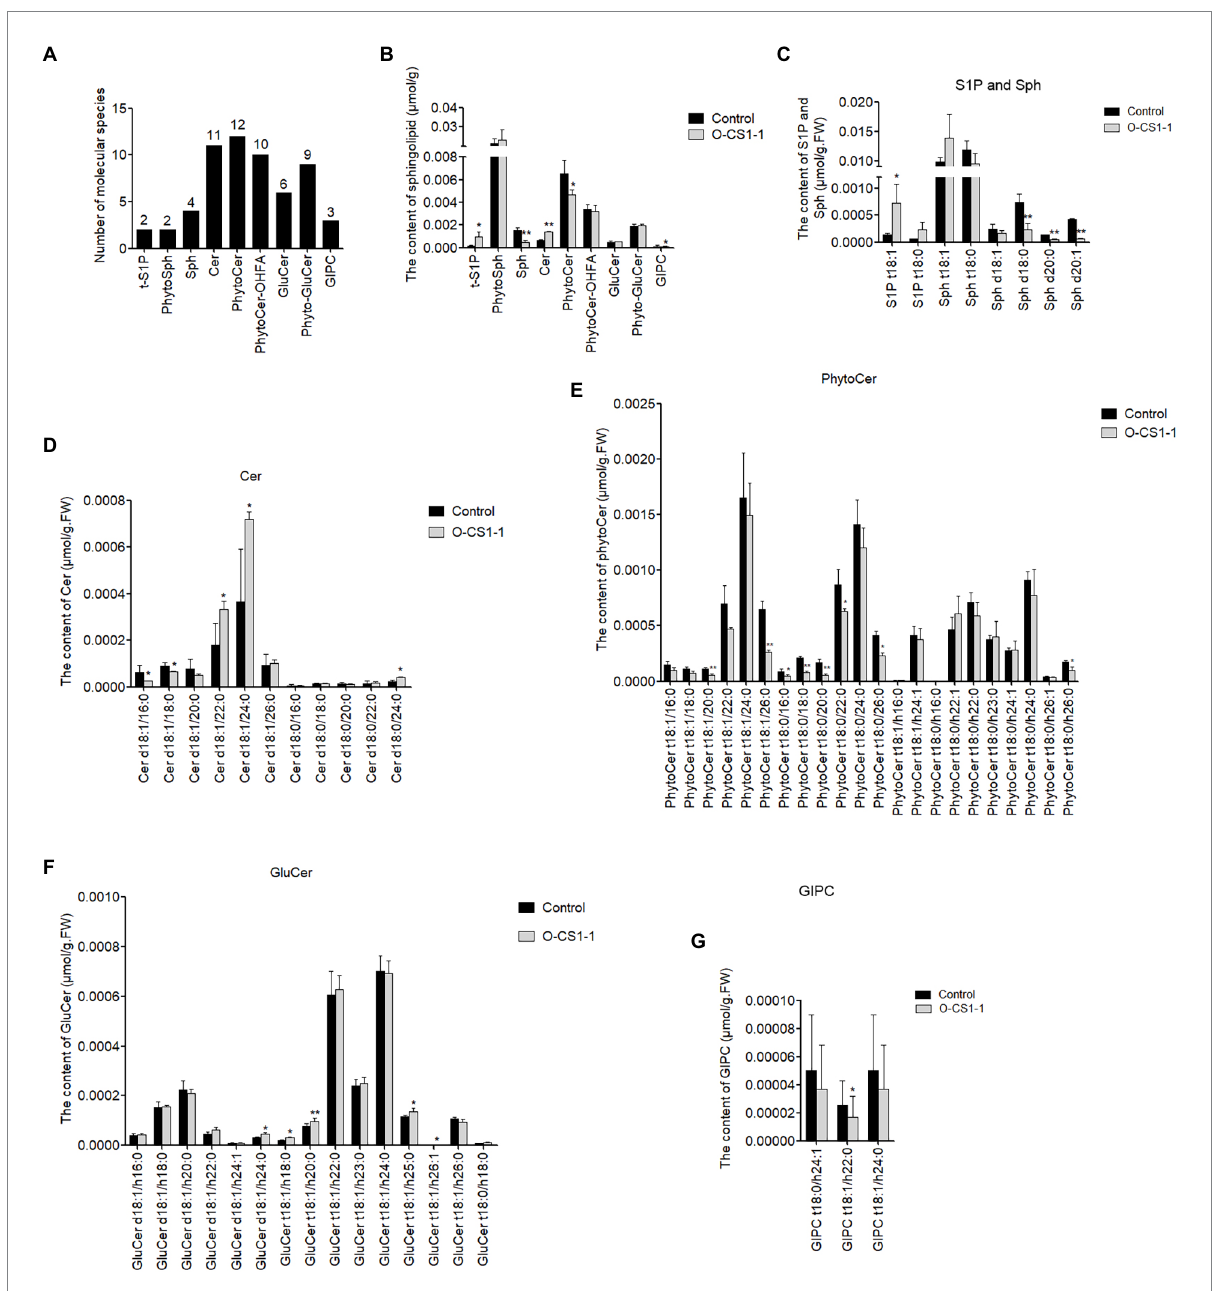
FIGURE 7 The difference of sphingolipid between control and transgenic 0-DPA ovule (with fiber cell). (A) Nine classes of sphingolipid detected and the number of each class in 0 - DPA ovule. (B) The total concentration of each class of sphingolipid in control and transgenic ovule (with fiber cell). (C–G) The types and contents of various sphingolipid molecules in control and transgenic ovules (with fiber cell). Cer: ceramides; GIPC: Glycosyl Inositol Phospho Ceramides; GluCer: glucosylceramides; Phyto-GluCer: phyto-glucosylceramides; Phyto-Cer: phyto-ceramides; Phyto-Cer- OHFA: Phyto-ceramides with hydroxylated fatty acyls; Phyto-Sph: phyto-sphingosines; Sph:sphingosines; t-S1P: phyto-S1P. Data underwent a Student’s t -test: * and ** indicate p < 0.05 and p < 0.01, respectively, vs. the